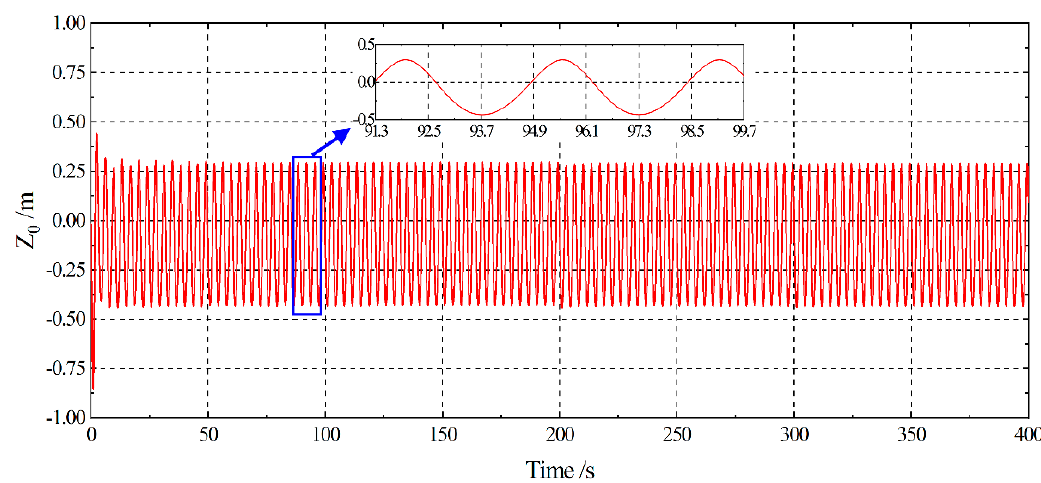
Figure 12. Time history of vertical trajectory of the towing point.